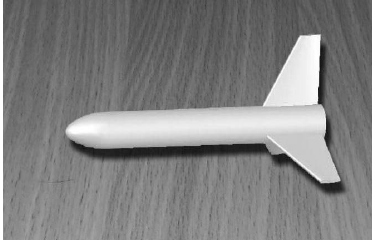
Fig.1 The fused deposition method (FDM) process